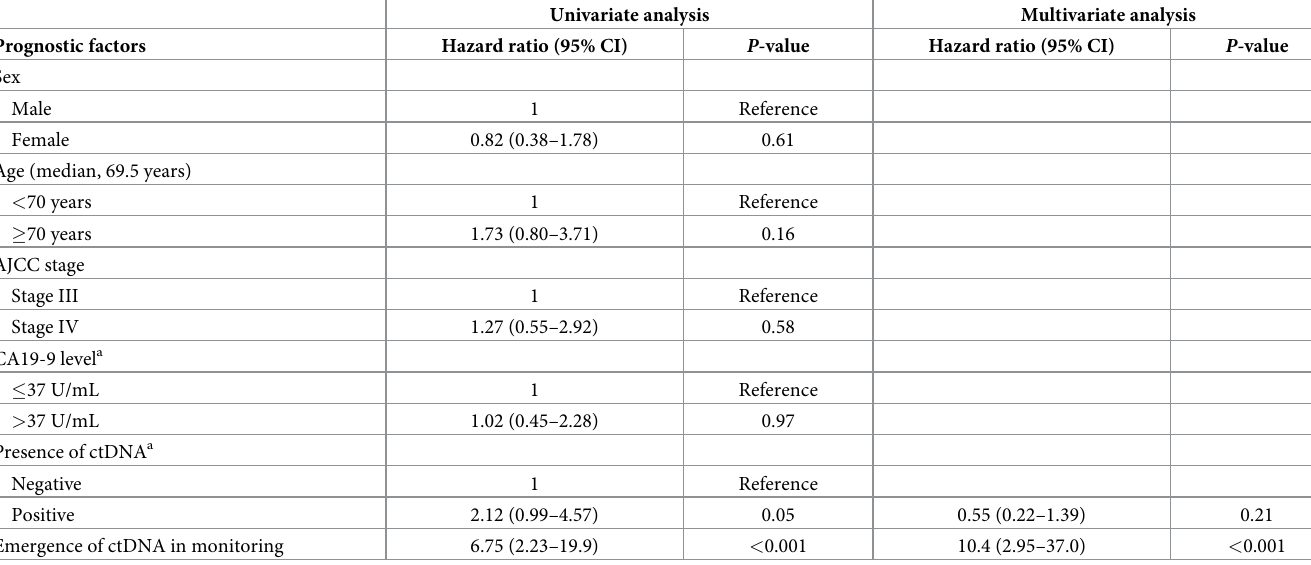
Table 2. Univariate and multivariate analyses of overall survival in patients who did not undergo surgery.